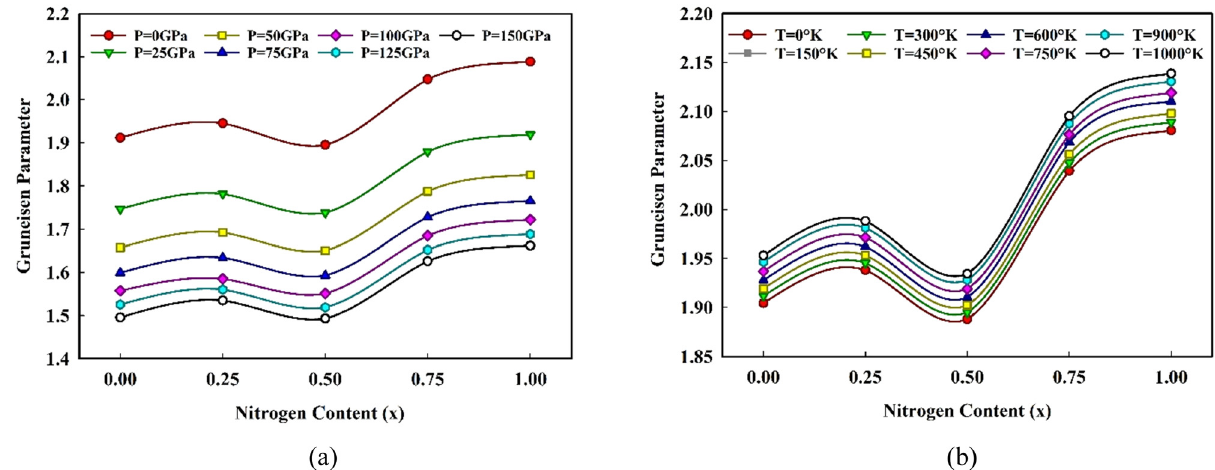
Figure 5: Grüneisen of ZrC ( 1 − x ) N x as a function of nitrogen content ( x ) for ( a ) di ff erent pressures at 300 K and ( b ) di ff erent temperatures at zero